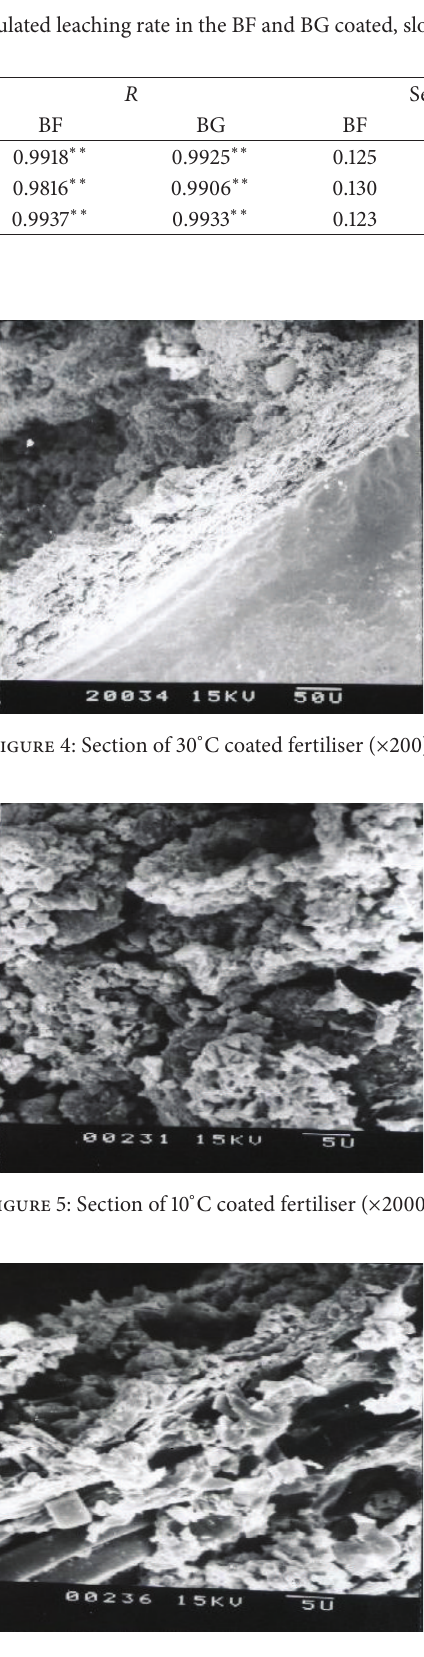
Figure 6: Membrane section of 30 ∘ C coated fertiliser ( ×